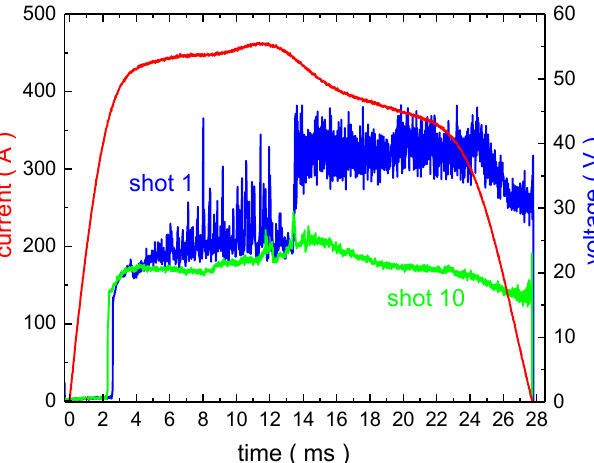
Figure 6. Electrical signals during the conditioning process. Red curve—arc current; blue and green curves—arc voltage during two different shots; blue curve before conditioning and green curve after conditioning.